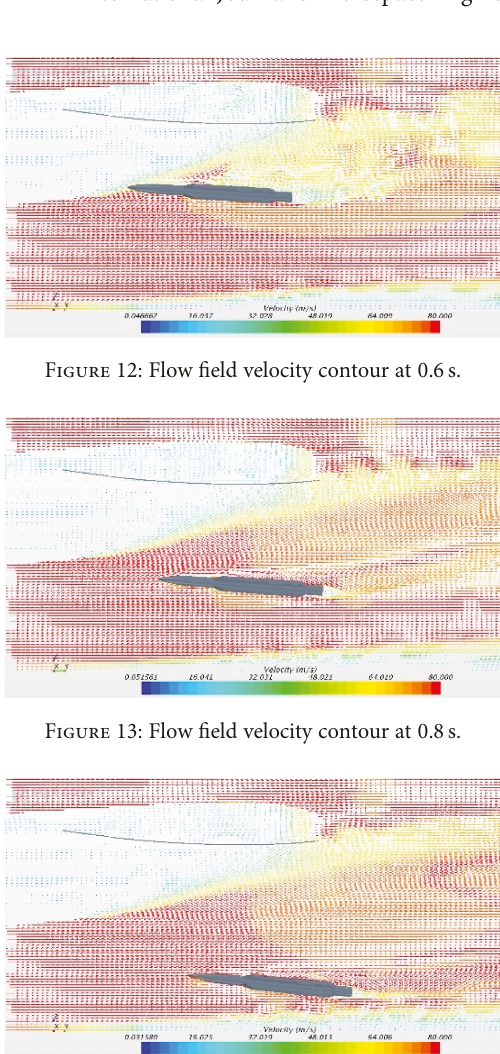
Figure 14: Flow fi eld velocity contour at 1.0s.